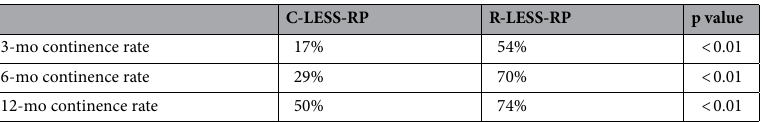
Table 4. Urinary incontinence recovery rate for PCa patients after operations ( χ 2 test). C-LESS-RP conventional laparoendoscopic single-site radical prostatectomy, R-LESS-RP Robot-assisted laparoendoscopic single-site radical